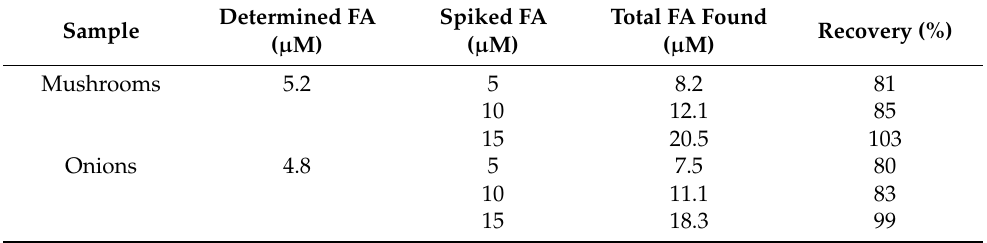
Table 1. The determination of FA ( µ M) in mushroom and onion extracts using probe EW2. Determined FA Spiked FA Total FA Sample ( µ M) ( µ M)